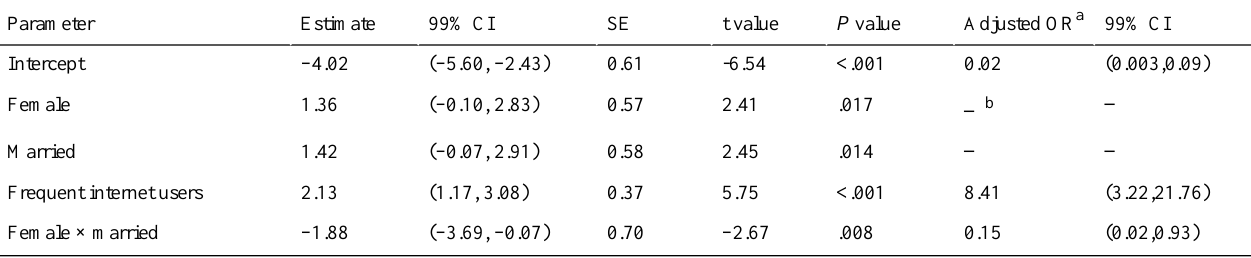
Table 4. Binary logit model for the likelihood of emailing a health care